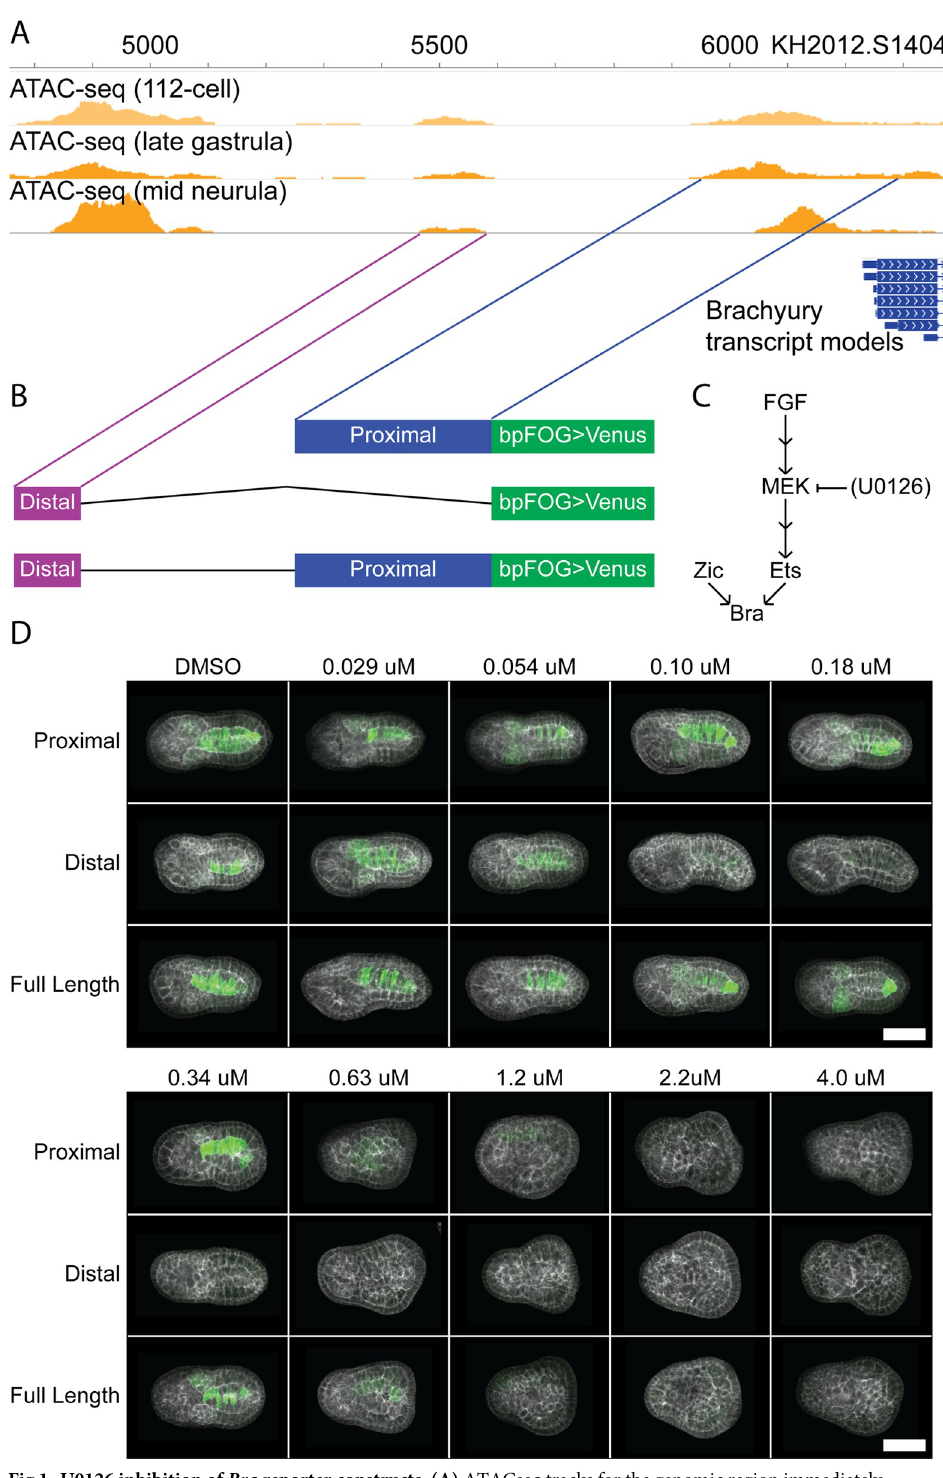
Fig 1. U0126 inhibition of Bra reporter constructs. (A) ATACseq tracks for the genomic region immediately upstream of Bra in wildtype Ciona embryos at the 112-cell, late gastrula, and mid neurula stages. (B) Schematic of reporter constructs used. A 340-bp Proximal enhancer, 116-bp Distal enhancer, and a construct spanning both enhancers with the wild-type 371-bp spacer region between them, each fused directly to the FOG basal promoter in front of a Venus YFP coding sequence. The lines connecting the Proximal and Distal enhancers to the ATACseq tracks